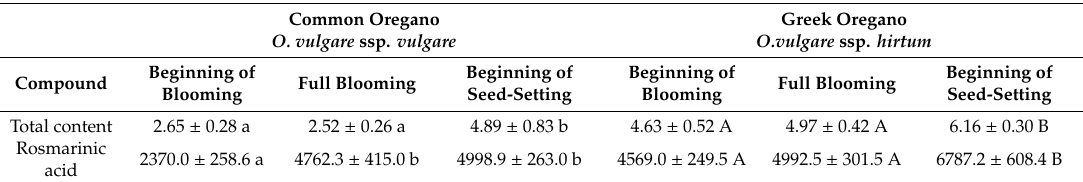
Table 6. The total content of phenolic acids (g × 100 g − 1 DW) and rosmarinic acid content (mg × 100 g − 1